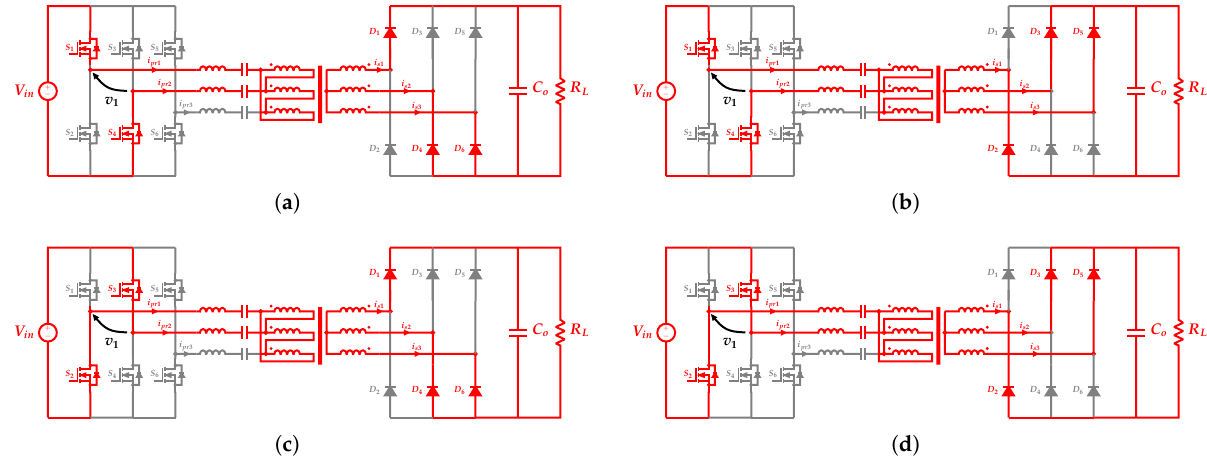
Figure 14. Circuit conditions in the single-phase mode: ( a ) Switches S 1 and S 2 turned on with positive current i s 1 ; ( b ) Switches S 1 and S 2 turned on with negative current i s 1 ; ( c ) Switches S 3 and S 4 turned on with positive current i s 1 ; ( d ) Switches S 3 and S 4 turned on with positive current i s 1